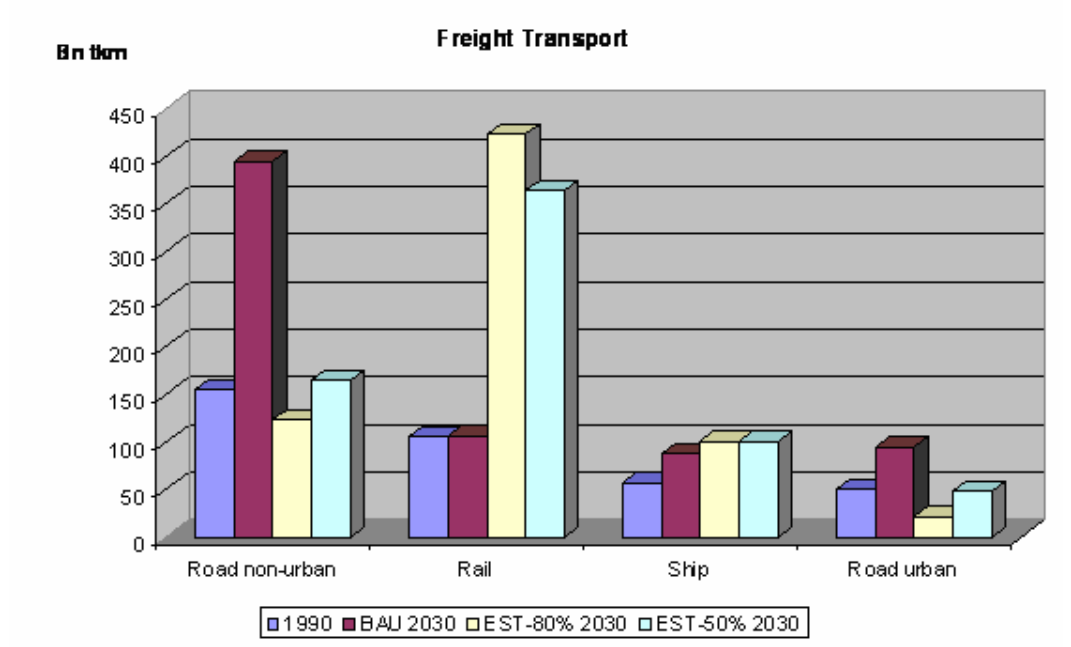
Figure 7. Comparison of Freight Transport in 1990 and in 2030 for BAU, EST-80% and